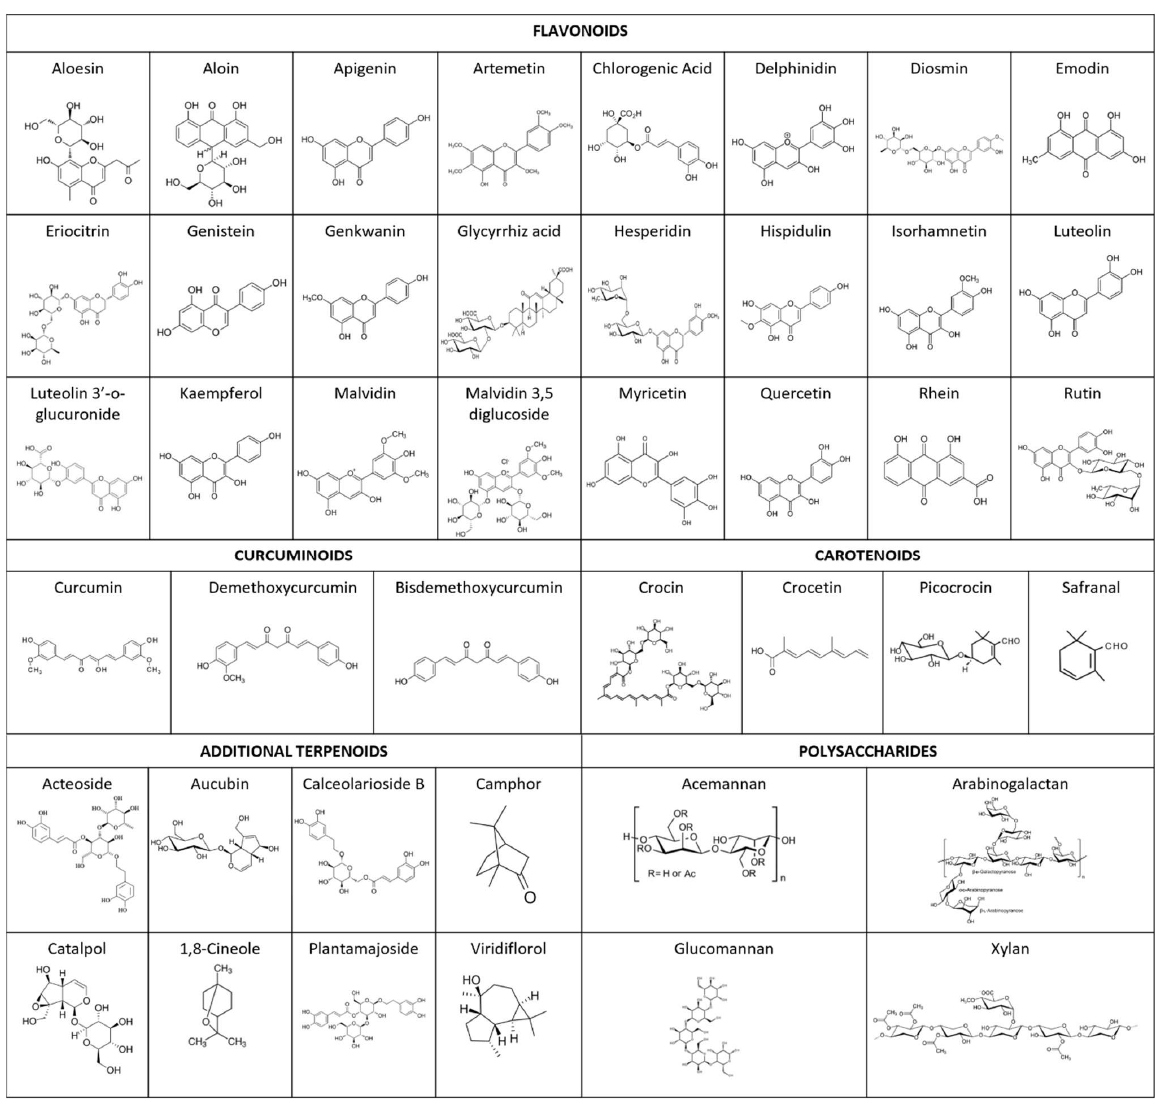
Figure 3. The primary bioactive phytochemical structures involved in wound healing.